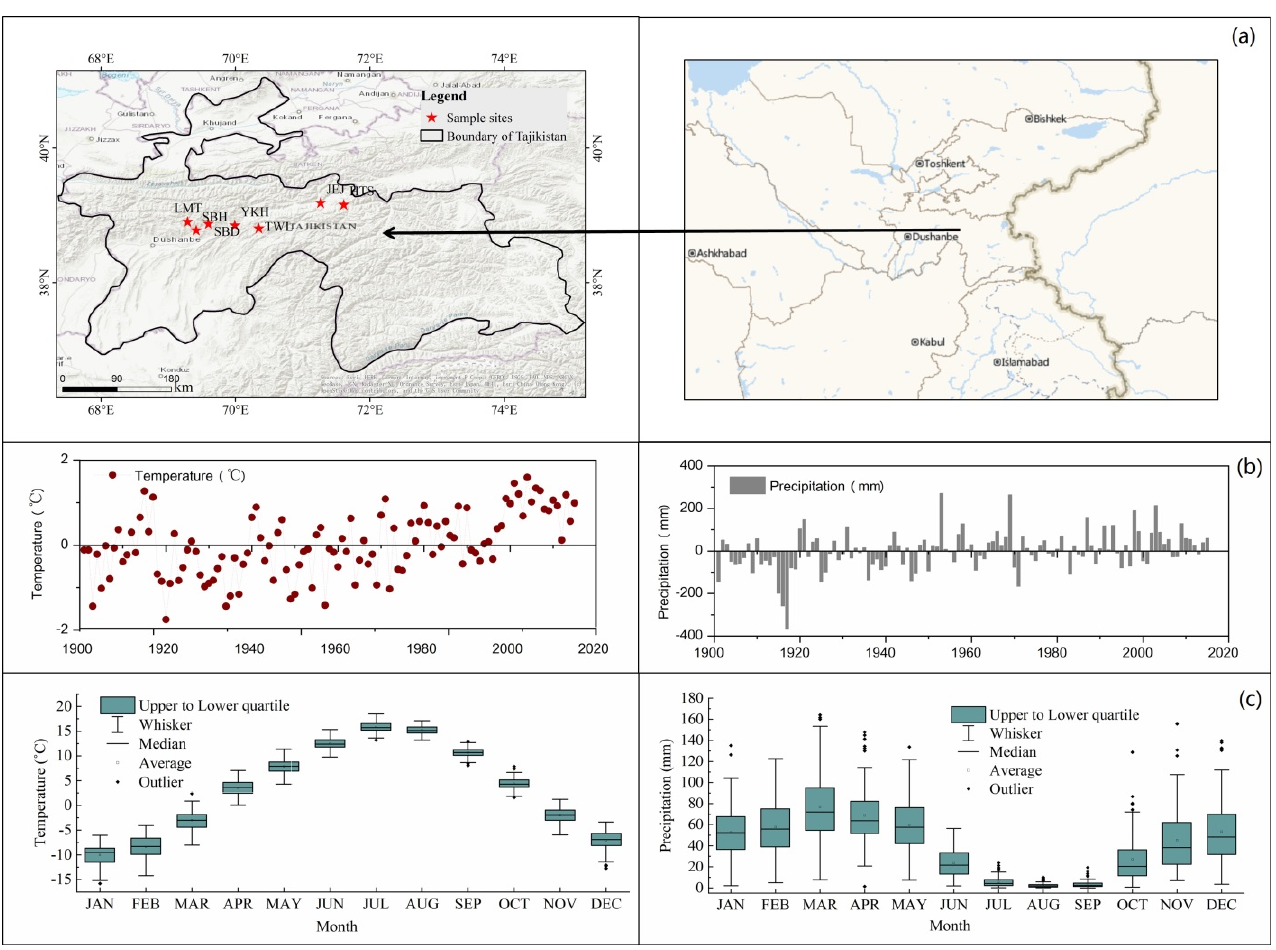
Figure 1. ( a ) Location of the juniper tree-ring sampling sites in Tajikistan; ( b ) long-term variations of temperature and precipitation cover the period of 1901–2015. Bars indicate annual precipitation anomaly (in mm), and curves with red color represent annual temperature anomaly (in °C).; ( c ) monthly variations in temperature and precipitation change in a year.